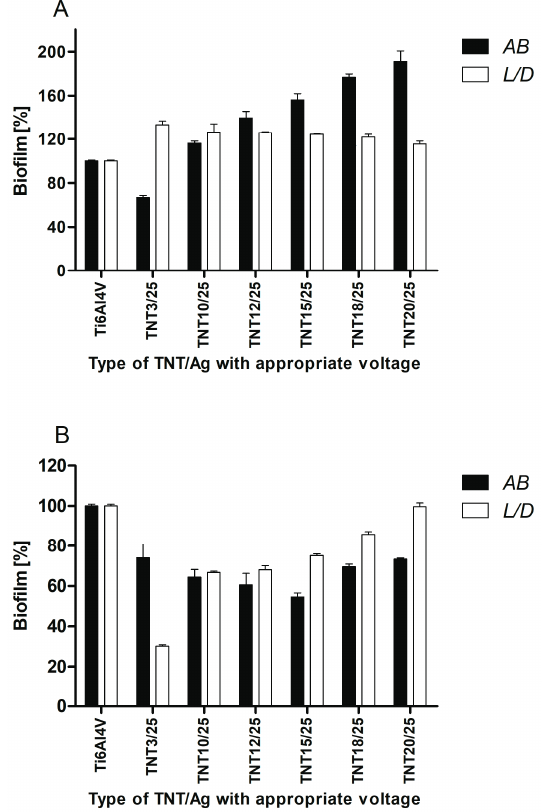
Figure 7. S. aureus ATCC 29213 biofilm (24 h old) on the surfaces of titanium nanotubes with dispersed silver particles formed after topical application of bacteria ( A ) or using suspension method ( B ), detected by Alamar Blue assay and Live/Dead BacLight Bacterial Viability kit (alive bacteria). The results are provided as the mean percentage ± standard deviation (SD) of staphylococcal biofilm compared to control biofilm developed on reference sample (Ti6Al4V) considered as 100%. All presented data (except biofilm on TNT20/25 assessed by L/D) were statistically significant ( p < 0.05).